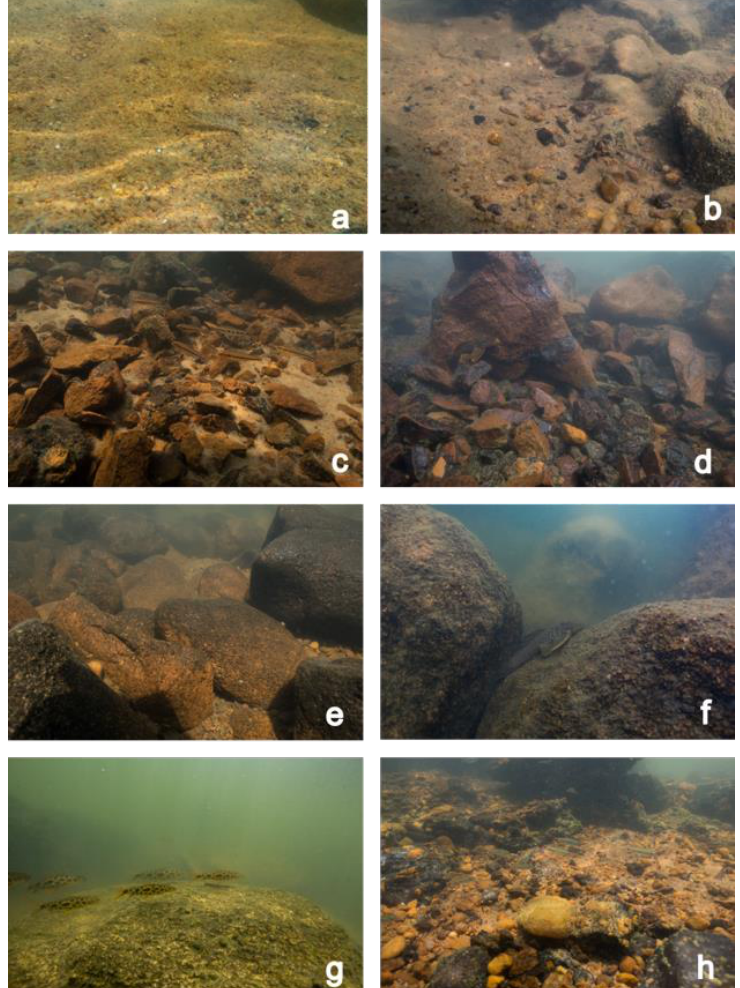
Figure 3. Examples of the habitat classes described in Table 1. ( a ) sand and pebbles with a large proportion of sand; ( b ) sand and pebbles; ( c ) cobbles; ( d ) gravel assemblages; ( e ) medium boulders; ( f ) large boulders; ( g ) solid rock (bedrock); ( h ) solid rock (textured).